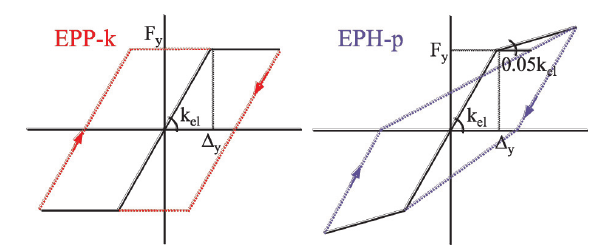
Figure 7. EPH-p and EPP-k SDoF constitutive relationships.